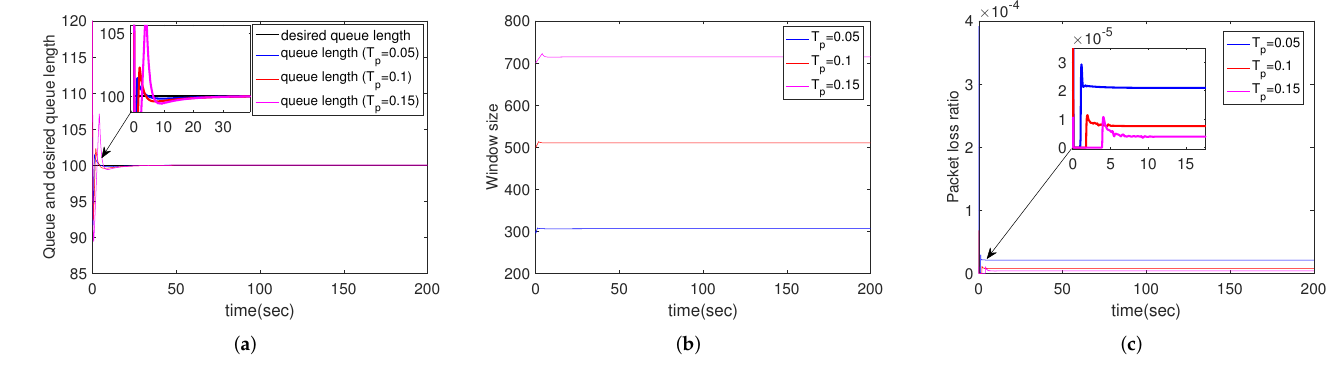
Figure 4. Simulation results of multiple routers using CCAIB for different propagation delays. Columns from left to right show the performance of CCAIB in ( a ) queue length stability, ( b ) window size and ( c ) packet loss ratio in the queue.